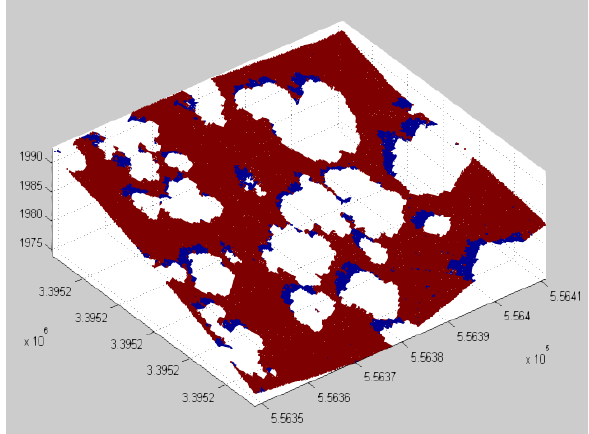
Figure 6: vegetation filtering from point